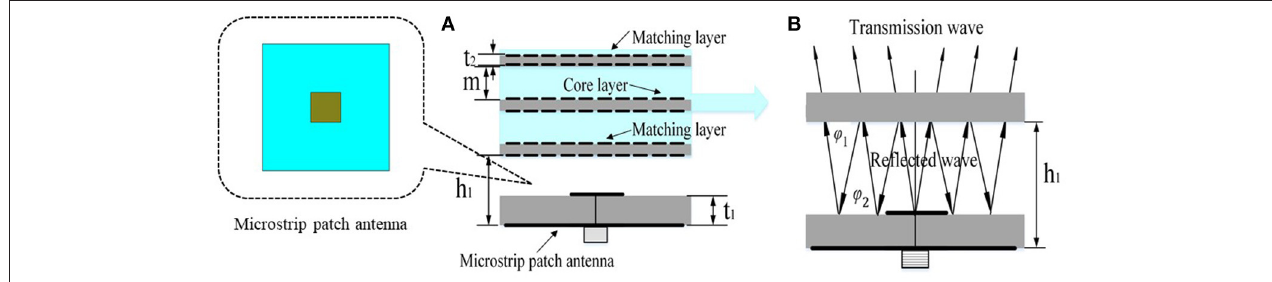
FIGURE 5 | (A) The side view of the proposed type I antenna. (B) The model of the antenna when the superstrate of three-layer metamaterial is looked as a whole.